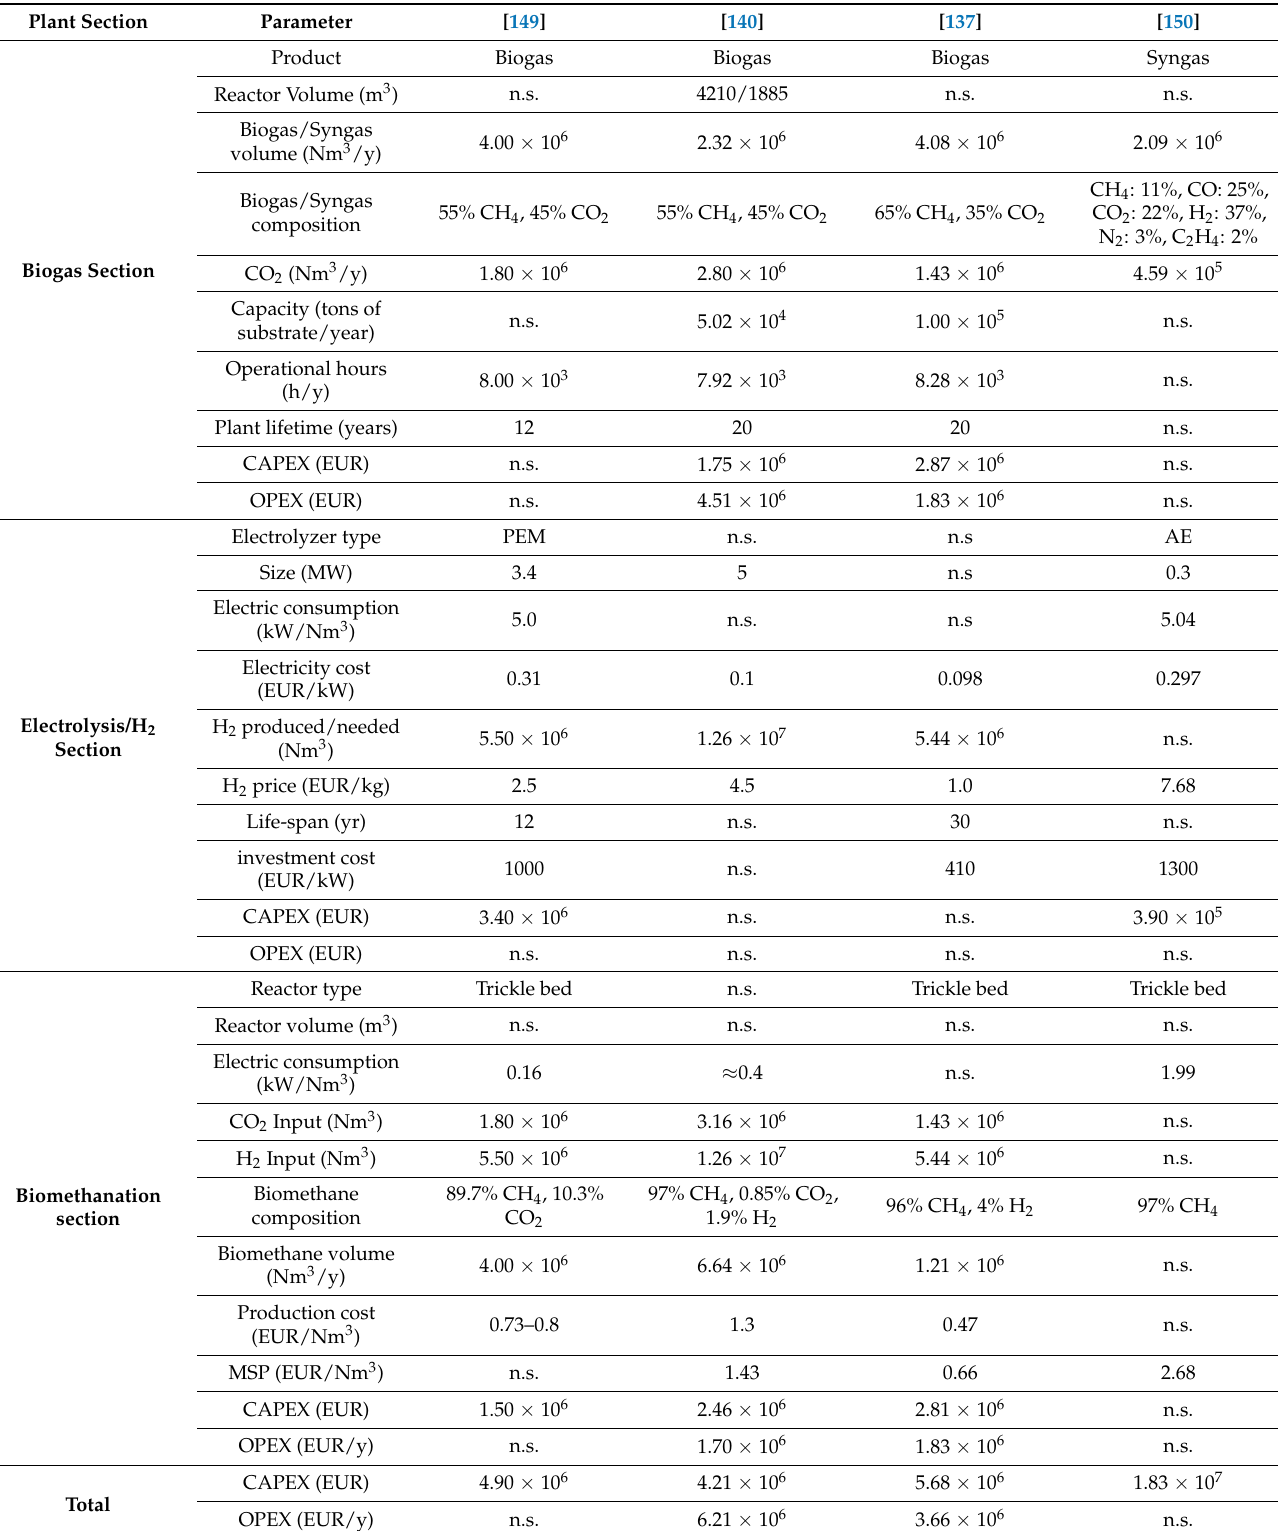
Table 3. Characteristics and parameters of biomethanation techno-economic analysis, parameters that were not specified from cited studies are reported as n.s. (not